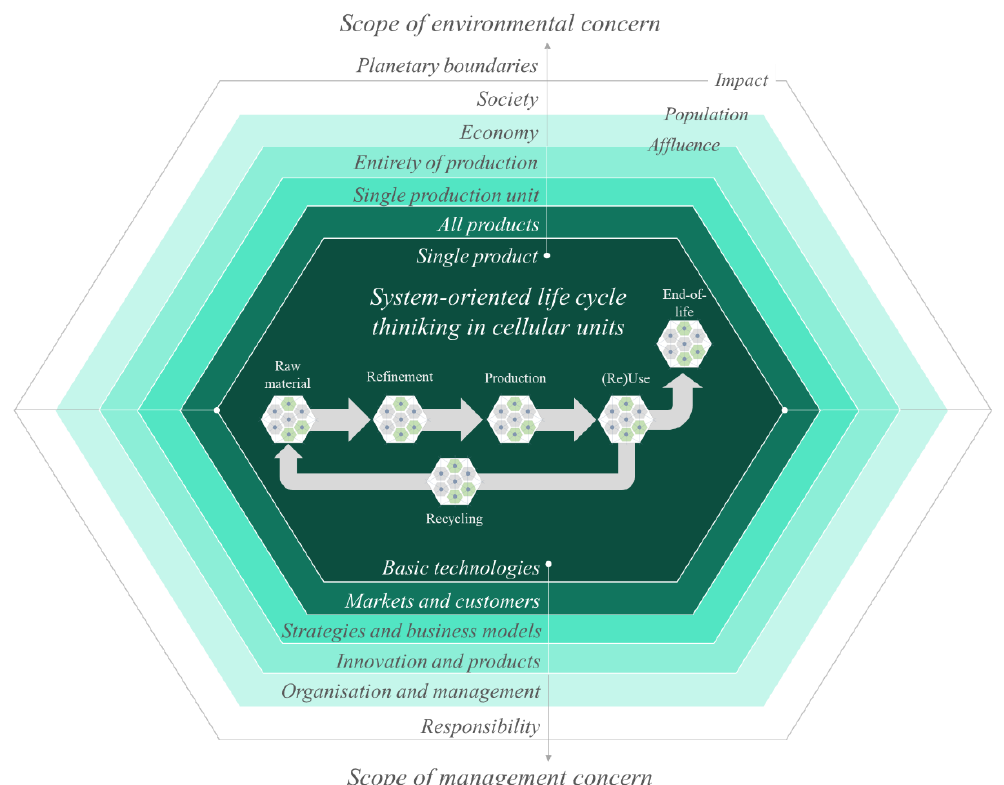
Figure 5. Framework for the management BIS (own illustration based on Stead and Stead [43] and Hauschild et al.